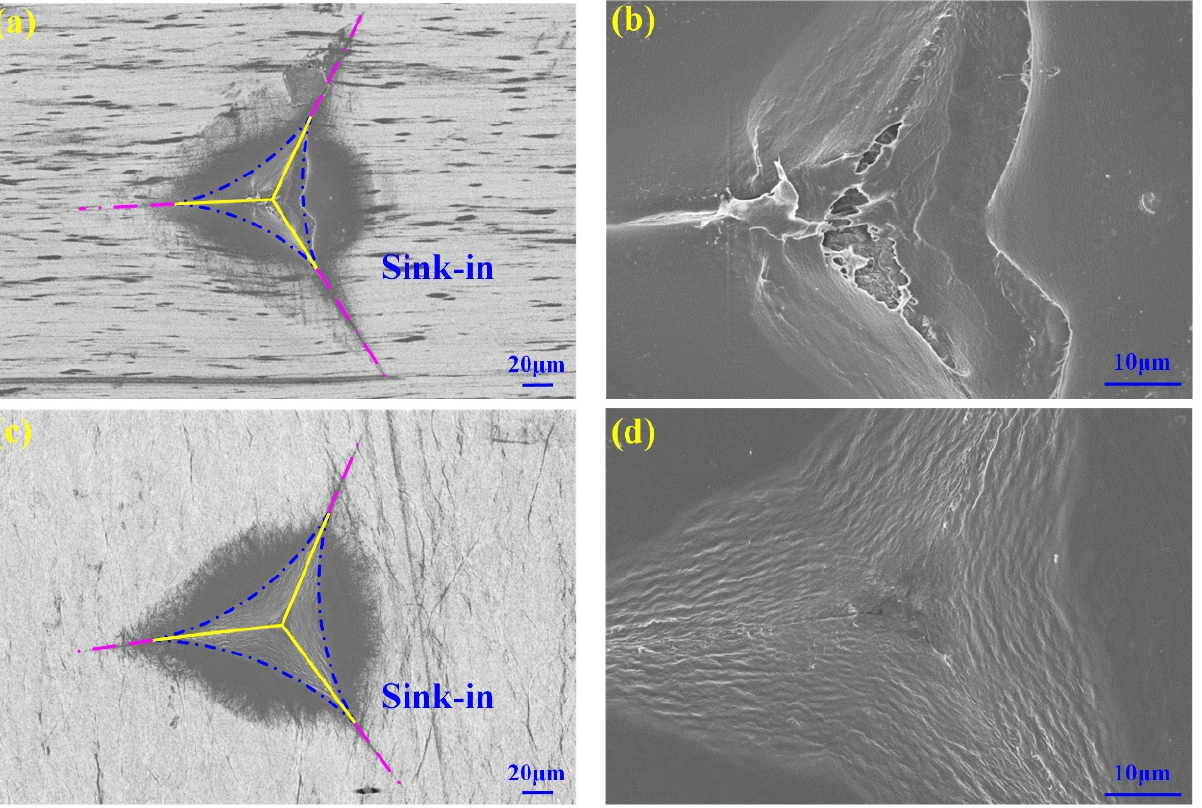
Figure 4. Micromorphology of in-plane view of specimens: ( a ) specimen 1 (300 times); ( b ) specimen 1 (1.5 × 10 3 times); ( c ) specimen 2 (300 times); ( d ) specimen 2 (1.5 × 10 3 times).